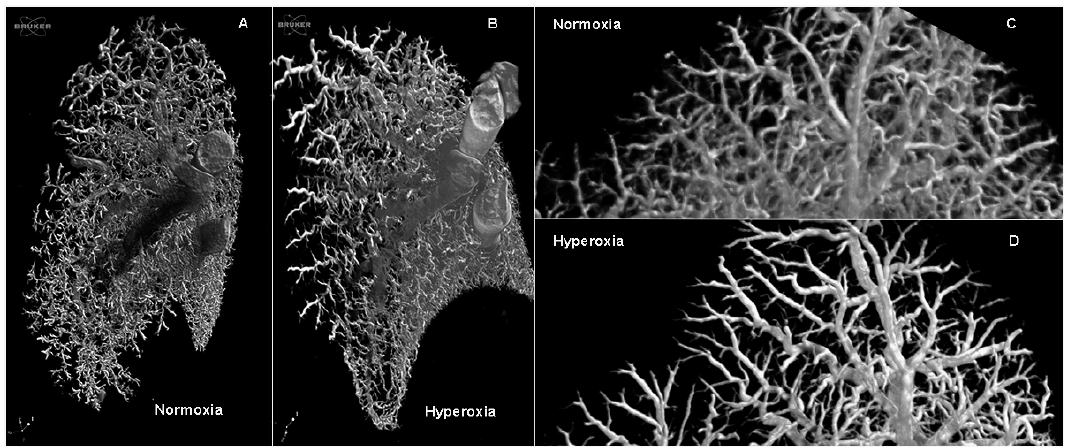
Figure 2. Representative images of Micro-CT of barium angiograms: Barium angiograms showed less distal vascular branches on pups exposed to hyperoxia: ( A ) Barium angiogram of a left lung of a normoxia exposed pup on day seven; ( B ) Barium angiogram of a left lung a hyperoxia-exposed pup on day seven; ( C ) higher detail of Panel A; ( D ) higher detail of Panel B.